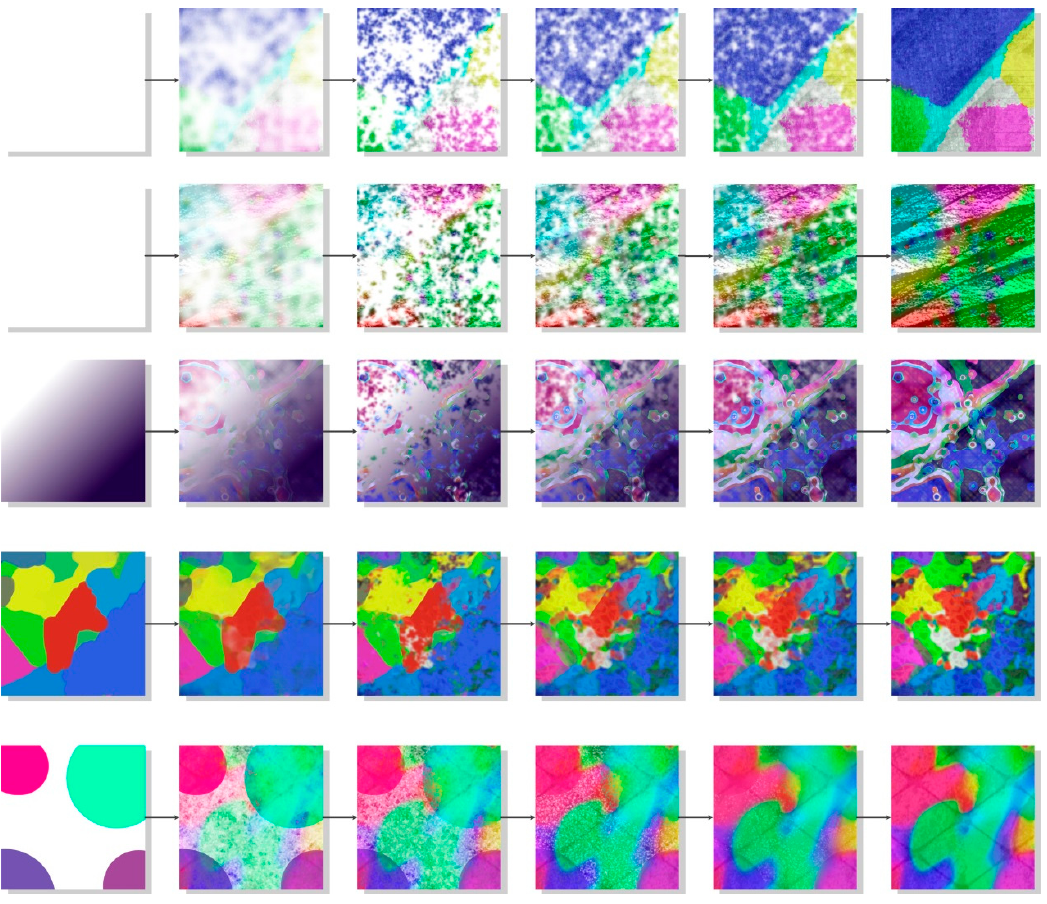
Figure 3. Original evolutionary art without a target. Each row represents a single run.